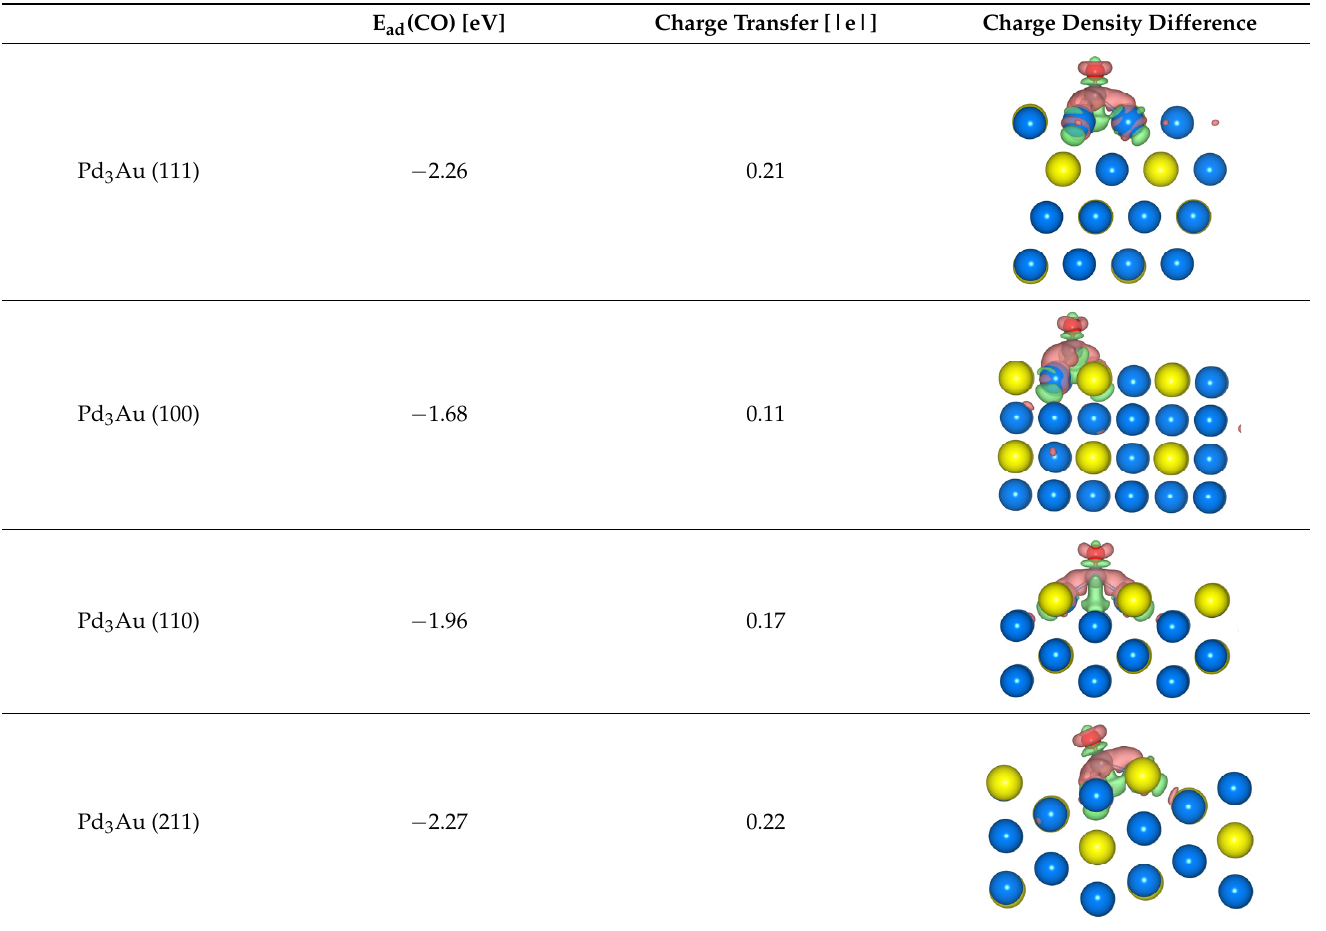
Table 1. CO adsorption energy, charge transfer, and charge density differences on different Pd 3 Au surface. E ad (CO) [eV]